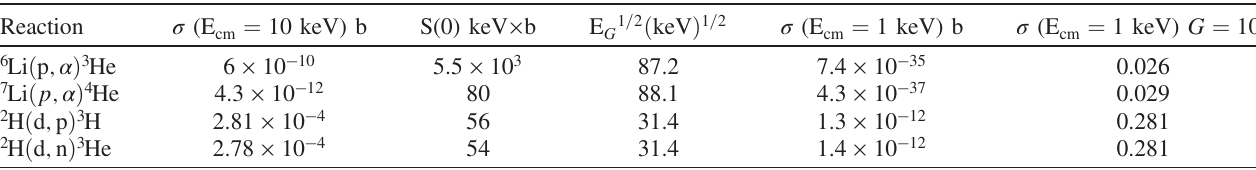
TABLE I. Actual values and expected increase of significant parameters for some relevant reactions.